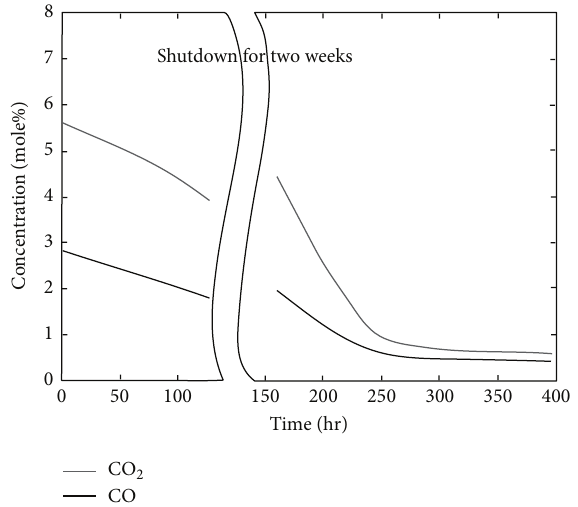
Table 2: Measured rate order of CH